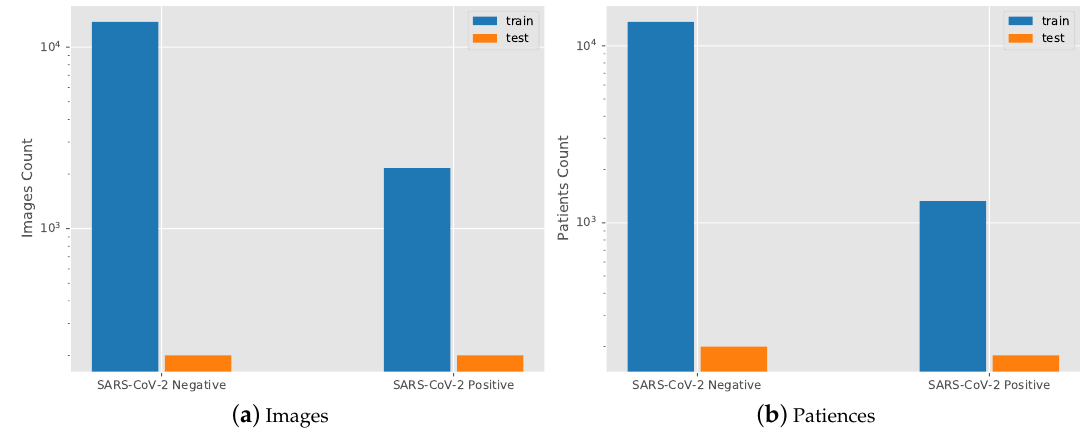
Figure 2. Chest X-ray image and patient distribution of SARS-CoV-2-negative and SARS-CoV-2-positive cases. ( a ) Images distribution. ( b ) Patients distribution.